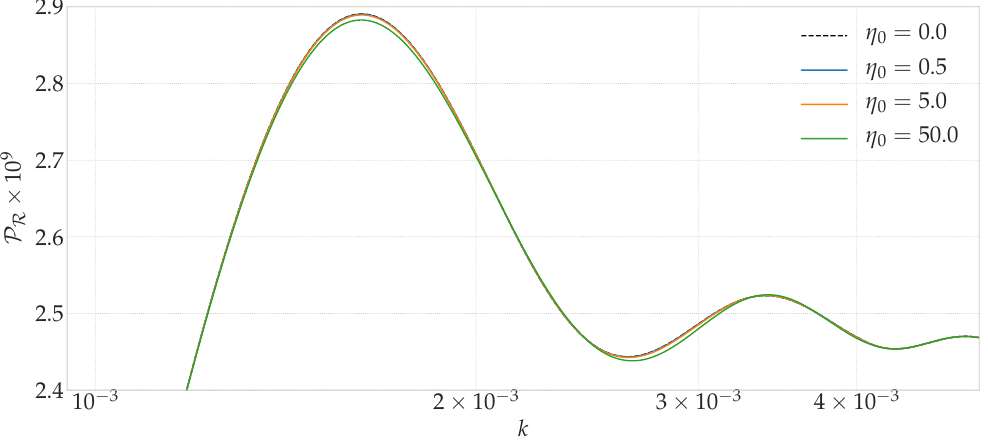
Figure 11. Primordial scalar power spectrum in hybrid LQC of the NO-vacuum defined with different choices of initial time between 0 (corresponding to the bounce) and 50, in Planck units. The background solution was studied in Section